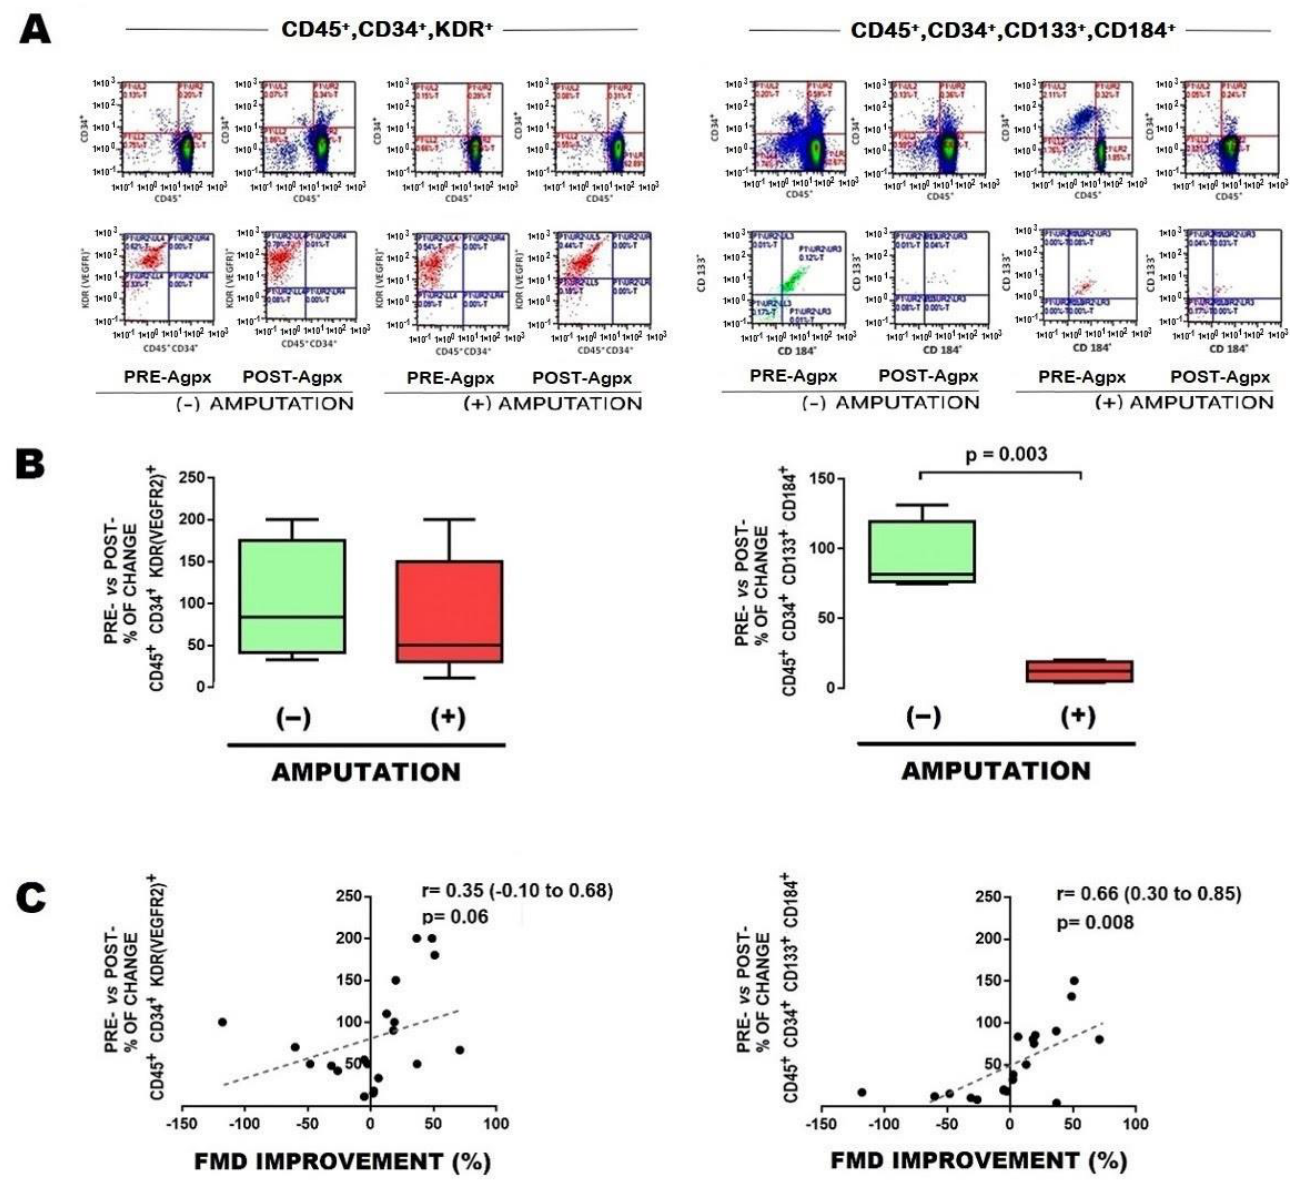
Figure 2. Postangioplasty changes in EPCs from patients with limb amputation. ( A ) Typical results of flow cytometry, with the markers used to identify EPCs, showing changes pre- vs. postangioplasty (PRE-Agpx vs. POST-Agpx) phases, either in EPCs CD45 + , CD34 + ,KDR [VEGFR2] + (left panel), or CD45 + ,CD34 + ,CD133 + ,CD184 + (right panel), in cases who evolved without limb amputation ( − ) and with limb amputation (+). ( B ) Graphics showing the percentage of change pre- vs. postangioplasty between cases who evolved without limb amputation ( − ) and with limb amputation (+). ( C ) Correlation between change in percentage of EPCs vs. change in flow-mediated dilation (FMD). Comparisons were made with U-Mann – Whitney and Kruskall – Wallis, 1-way. Abbreviations: EPCs, endothelial progenitor cells; PRE-Agpx, preangioplasty; POST-Agpx, postangioplasty; FMD, flow-mediated dilation.